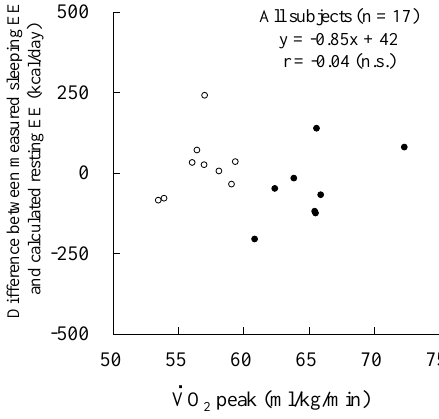
Figure 4. Relationship between V ． O 2 peak and the difference in measured sleeping energy expenditure and calculated resting energy expenditure. EE: energy expenditure; ● : very fit runners; ○ : fit runners.